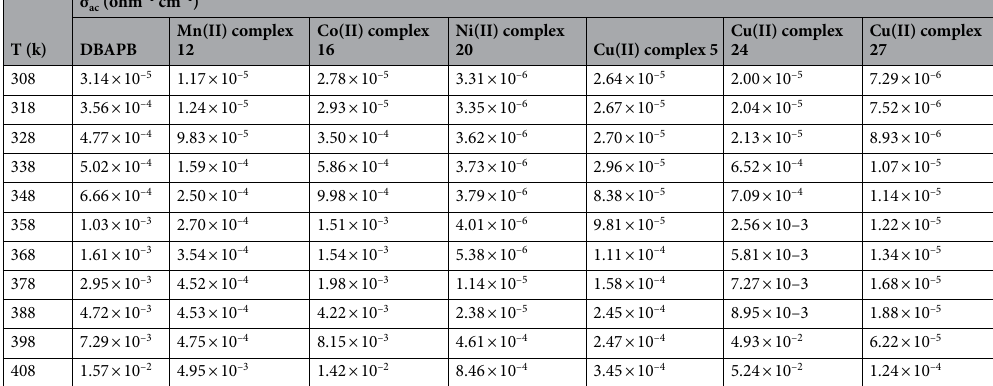
Table 10. Variation of AC conductivity (σ ac ) of the ligand, DBAPB, and its complexes 5, 12, 16, 20, 24, 27 with temperature, at frequency = 10 kHz.